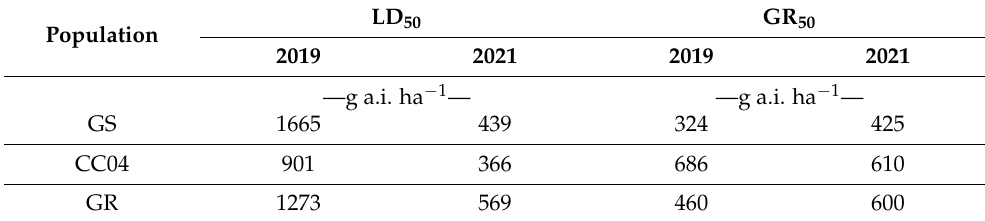
Table 8. Glufosinate dose required to kill 50% of plants (LD 50 ) or cause a 50% reduction in growth (GR 50